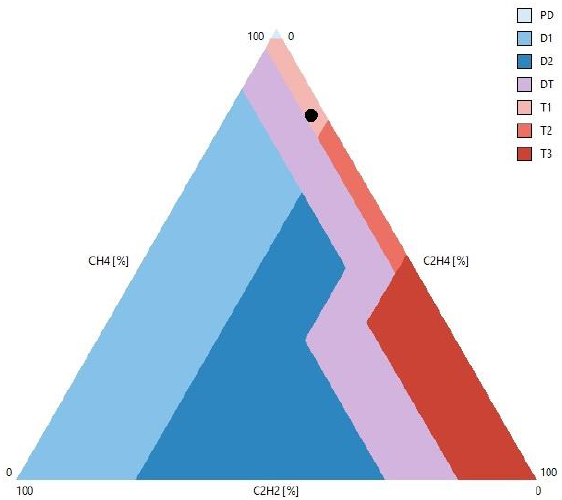
Figure 5. Defect indicated by the Duval Triangle Method for 40/20/20 MVA, 115/16.5/16.5 kV power transformer.